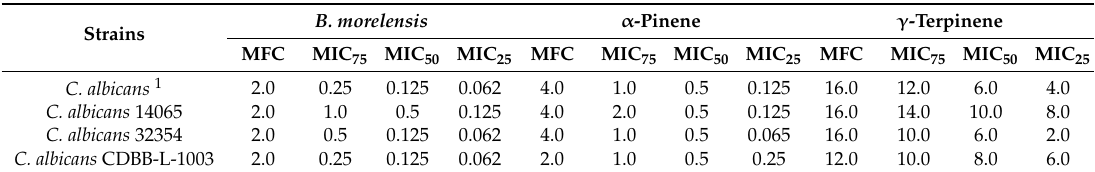
Table 3. MIC (Minimal Inhibitory Concentration) and MFC (Minimum Fungicidal Concentration) of essential oil and pure